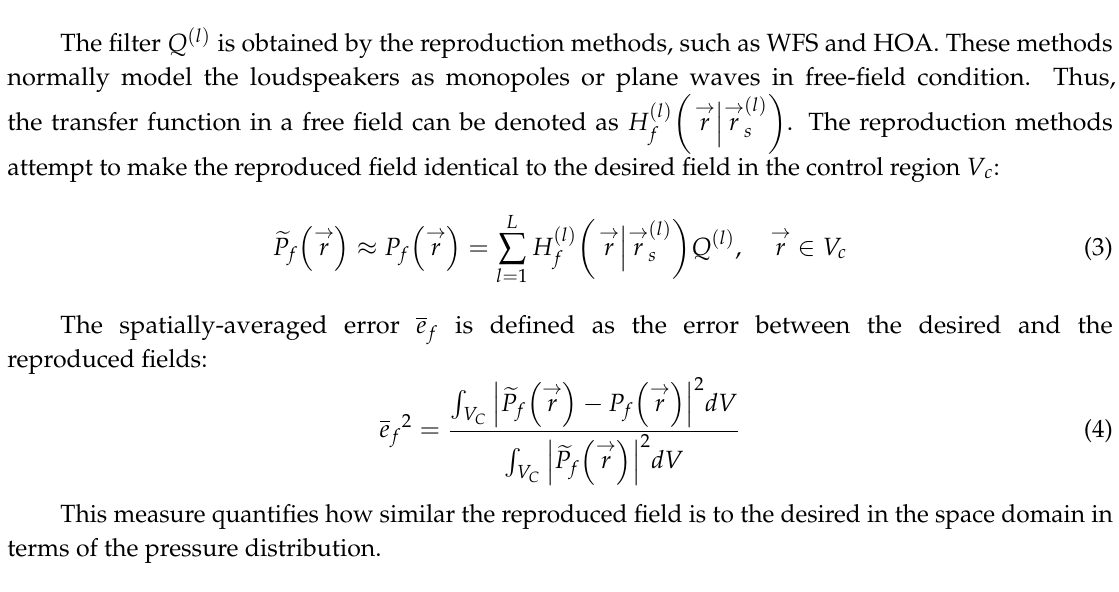
Figure 1. A typical sound field reproduction system in a listening room.